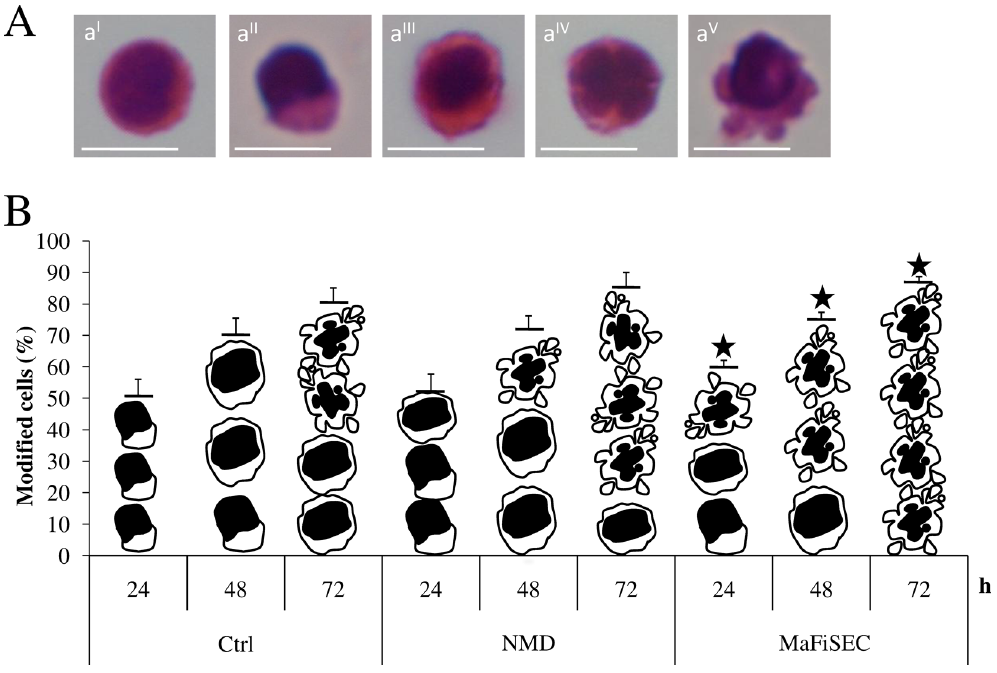
Figure 4. Morphologies of unexposed and SMF-exposed lymphocytes. (A): LM micrographs of H-E stained lymphocytes: typical normal (a I ) and altered (a II–V ) morphologies of unexposed and SMF-exposed lymphocyte respectively; (a II ) an example of a lymphocyte with elongate shape; (a III– V ) typical features of apoptosis: a lymphocyte with a pyknotic nucleus and rough surface (a III ), condensed chromatin and fragmented nucleus (a IV ) and extensive cell surface blebbling (a V ). Bars=10 m m. (B): schematic drawings of the different morphologies of lymphocytes, representing the pictures in A, show the percentage of incidences of the different modified morphologies during 72 h of SMF exposure to NMD and MaFiSEC. Each height of the histogram is the sum of the percentages of modified cells indicate at the lines 2–4 of the table 1. Control value is the average of the values of unexposed cells cultured by using either flasks or Petri dishes. Ctrl=unexposed lymphocytes; h=hours. Star indicates significant value with respect to unexposed and NMD-exposed cells (p ,